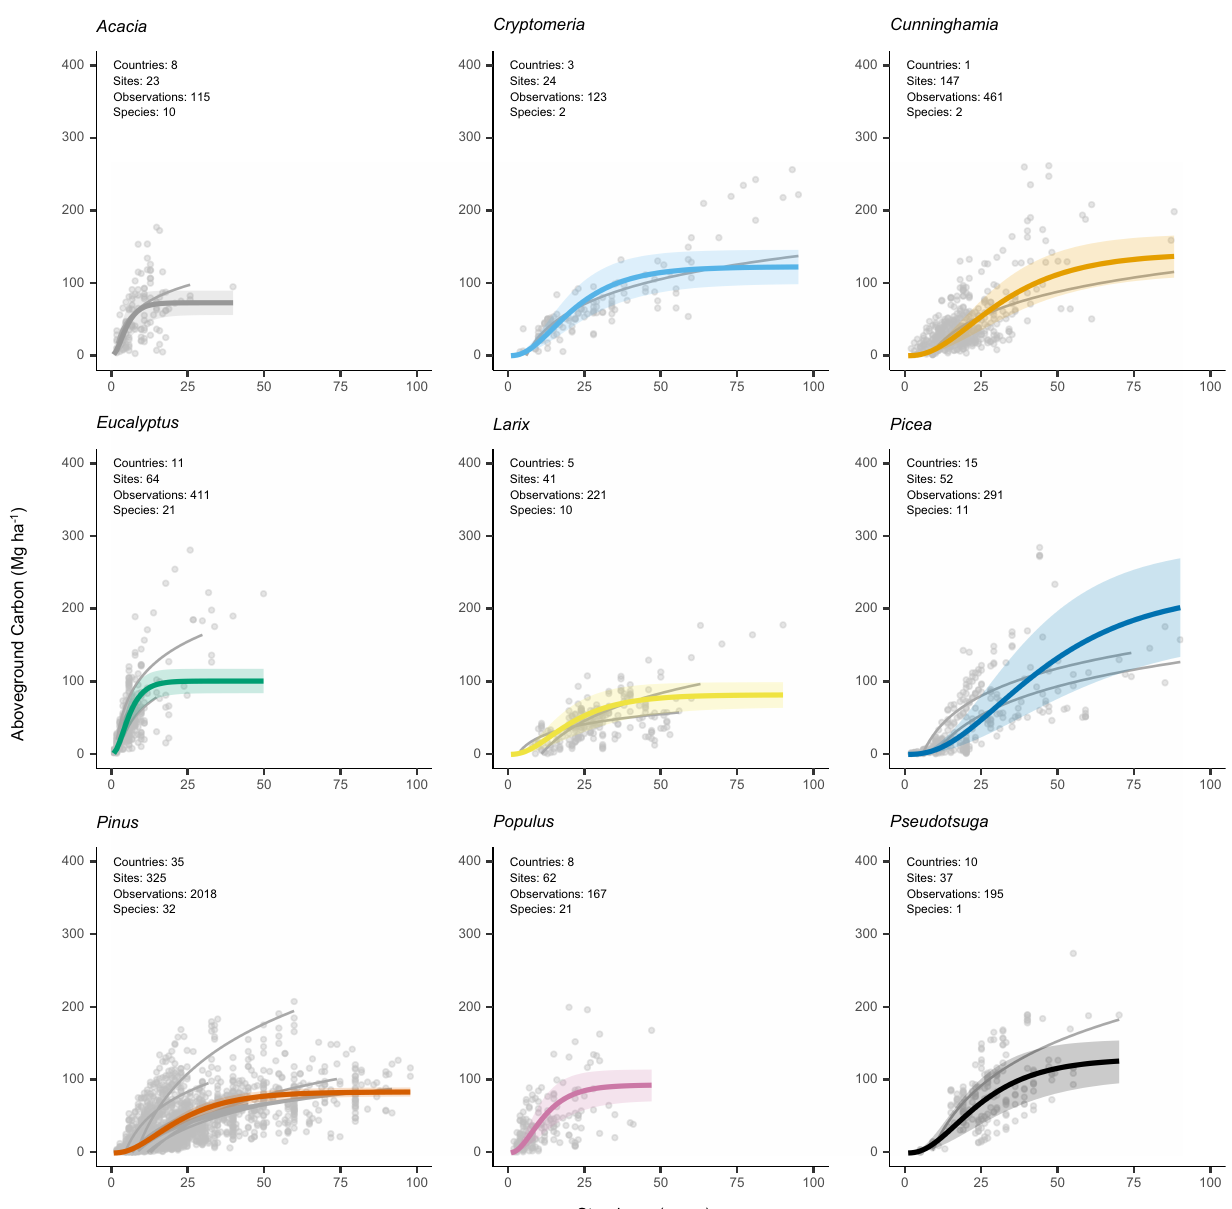
Fig. 4 Growth functions by genus. Parameterized Chapman-Richards growth functions, with the shaded areas around curves denoting 95% con fi dence interval of predictions based on fi xed effects only. The grey curves (for visual comparison of species level trends) are logarithmic relationships between stand age and aboveground carbon for individual species with greater than 40 observations in the